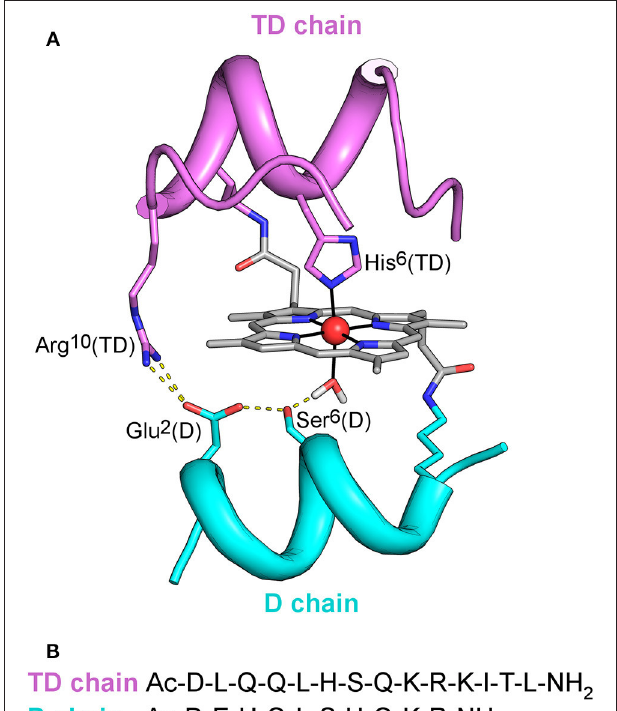
FIGURE 1 | (A) MC6 * a designed model. Backbone of peptide chains is depicted as ribbon. Side-chains of functional and structural residues are depicted as sticks, and the metal ion as red ball. The designed hydrogen bonding network, involving Arg 10 in the TD chain, Asp 1 , Ser 6 in the D chain, and the metal-bound water molecule is also highlighted. (B) Peptide sequences of TD and D peptide chains. U denotes the α , α -dimethyl glycine (Aib)